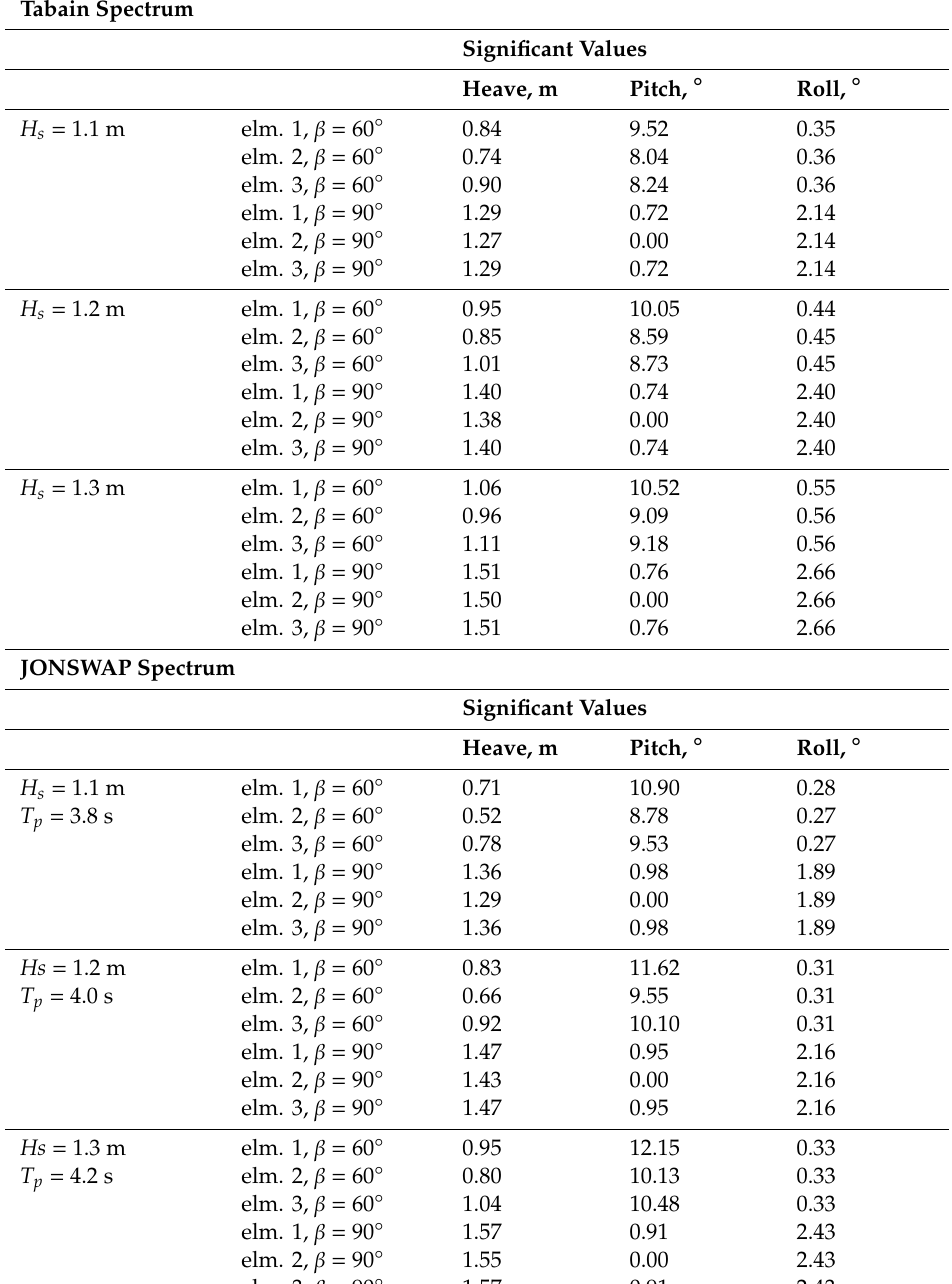
Table 2. Significant values of the motions of the